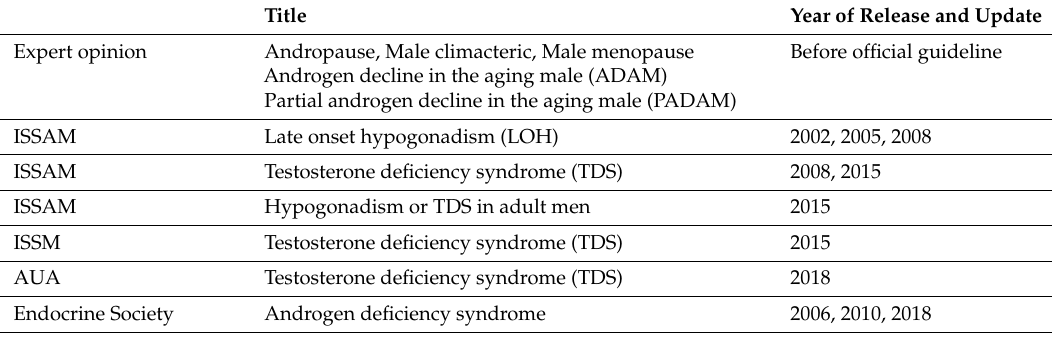
Table 2. Evolution of nomenclature and